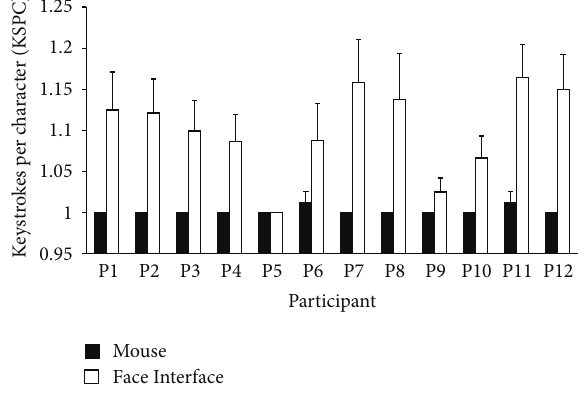
Figure 12: KSPC values by